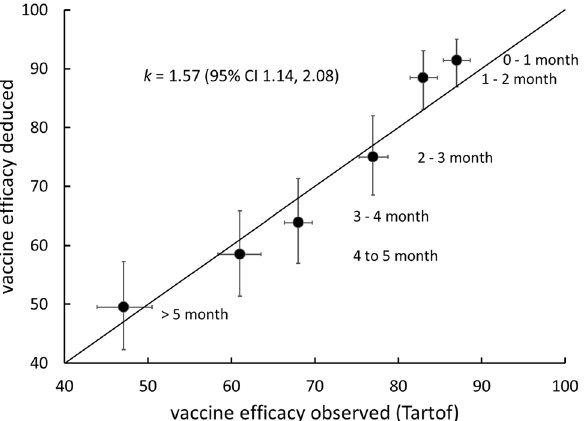
Figure 1. Comparison of vaccine efficacy (expressed as %) computed from Eq. 6 with observed efficacy. Log- normal mean, μ , of antibody concentration distributions are the median values given by Israel et al. 14 Random sampling from the assumed normal distribution of σ deduced from the various estimates given the data of Israel et al. and from the vaccine efficacy confidence intervals given by Tartof et al. 7 , minimising the sum of squared deviations by varying c 50 and k . Error bars are 95% confidence